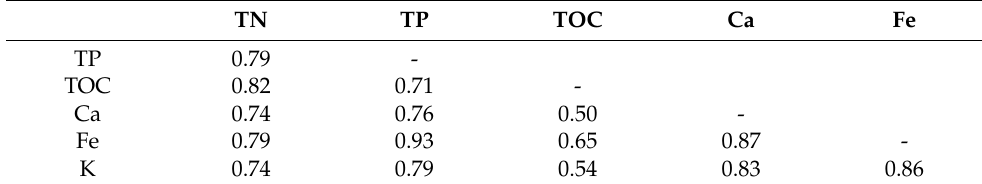
Figure 6. Variation of the concentrations of TN, TP, TOC, Ca, Fe and K in the bottom sediments of analysed rivers. Table 4. Correlation coefficients between analysed